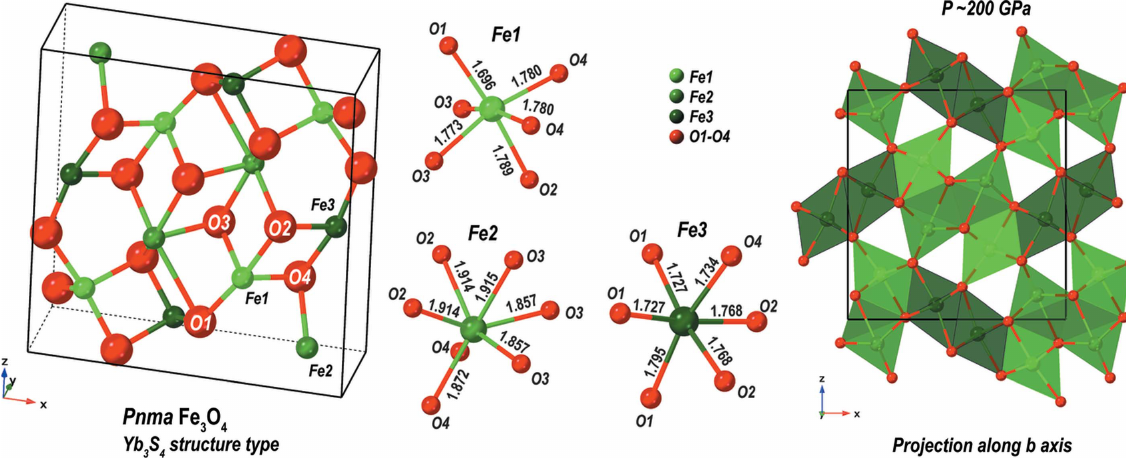
Figure 8 The crystal structure of Pnma Fe 3 O 4 formed after laser heating at 3000–3500 K. The structure is composed of layers of distorted octahedra (Fe1 and Fe3 sites) which are interconnected through the capped trigonal prisms (Fe2 sites). The structure solution converged to R ( F 2 ) = 0.071, wR ( F 2 ) = 0.075 using reflections with an intensity I > 2 (cid:2) ( I ). The individual building blocks and the corresponding Fe—O bonds are shown. On the right-hand side is a projection of the structure along the b axis, providing a clear indication of edge sharing of the corresponding building blocks and an overview of the Fe–O